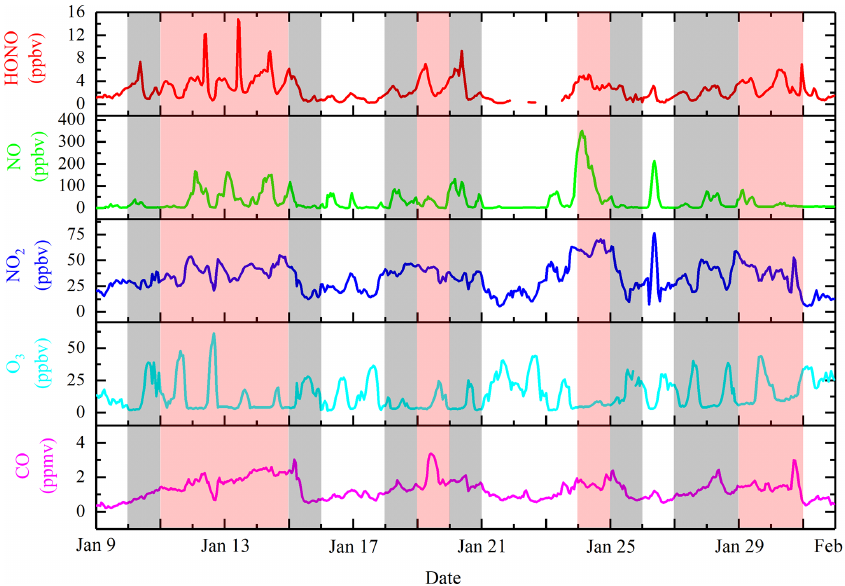
Figure 2. Temporal variations of hourly averages for HONO, NO, NO 2 , O 3 , and CO during the measurement. (The shaded areas are as follows: white for the CDs period; gray for the PDs period; and red for the SPDs period.)